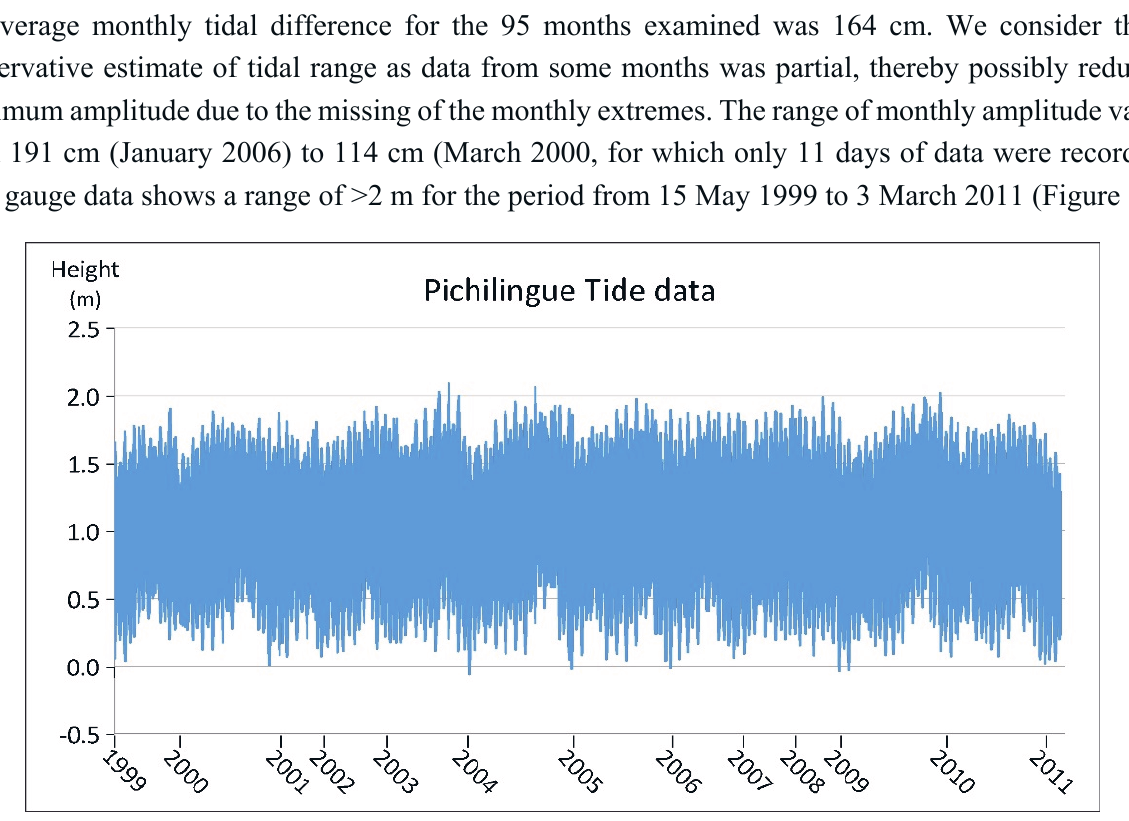
Figure 8. Tide heights at Pichilingue gauge station for the period 15 May 1999 to 3 March 2011. A tidal amplitude of 1.64 m equates to potential elevation range of ~2–3.6 m above water level